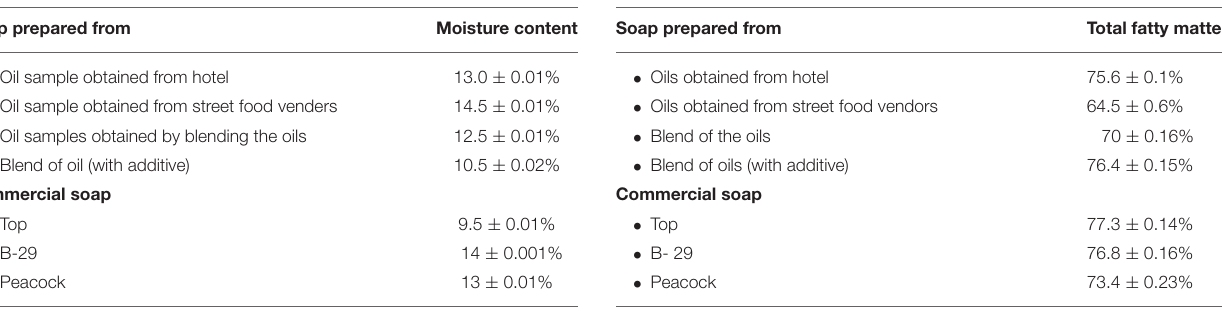
TABLE 2 | The moisture content value of the prepared soap materials and commercial soap samples.